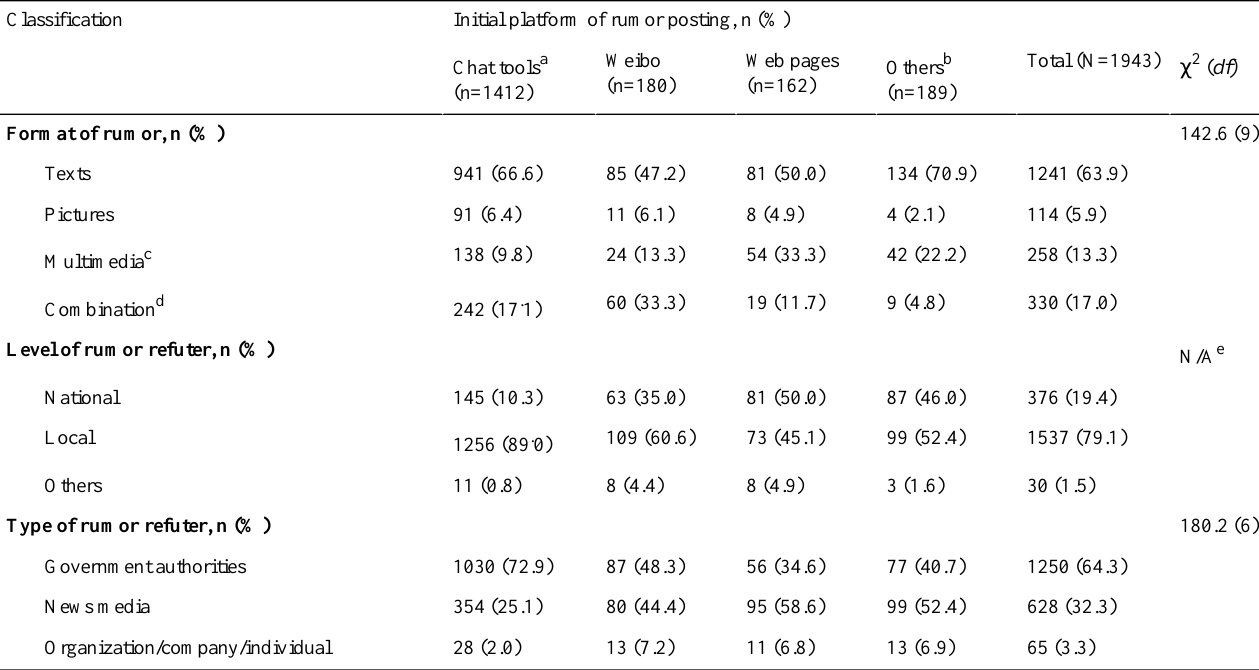
Table 3. Comparison of different rumor posting platforms between January 20 and April 8, 2020 (N=1943). P <.001 for all categories. Initial platform of rumor posting, n